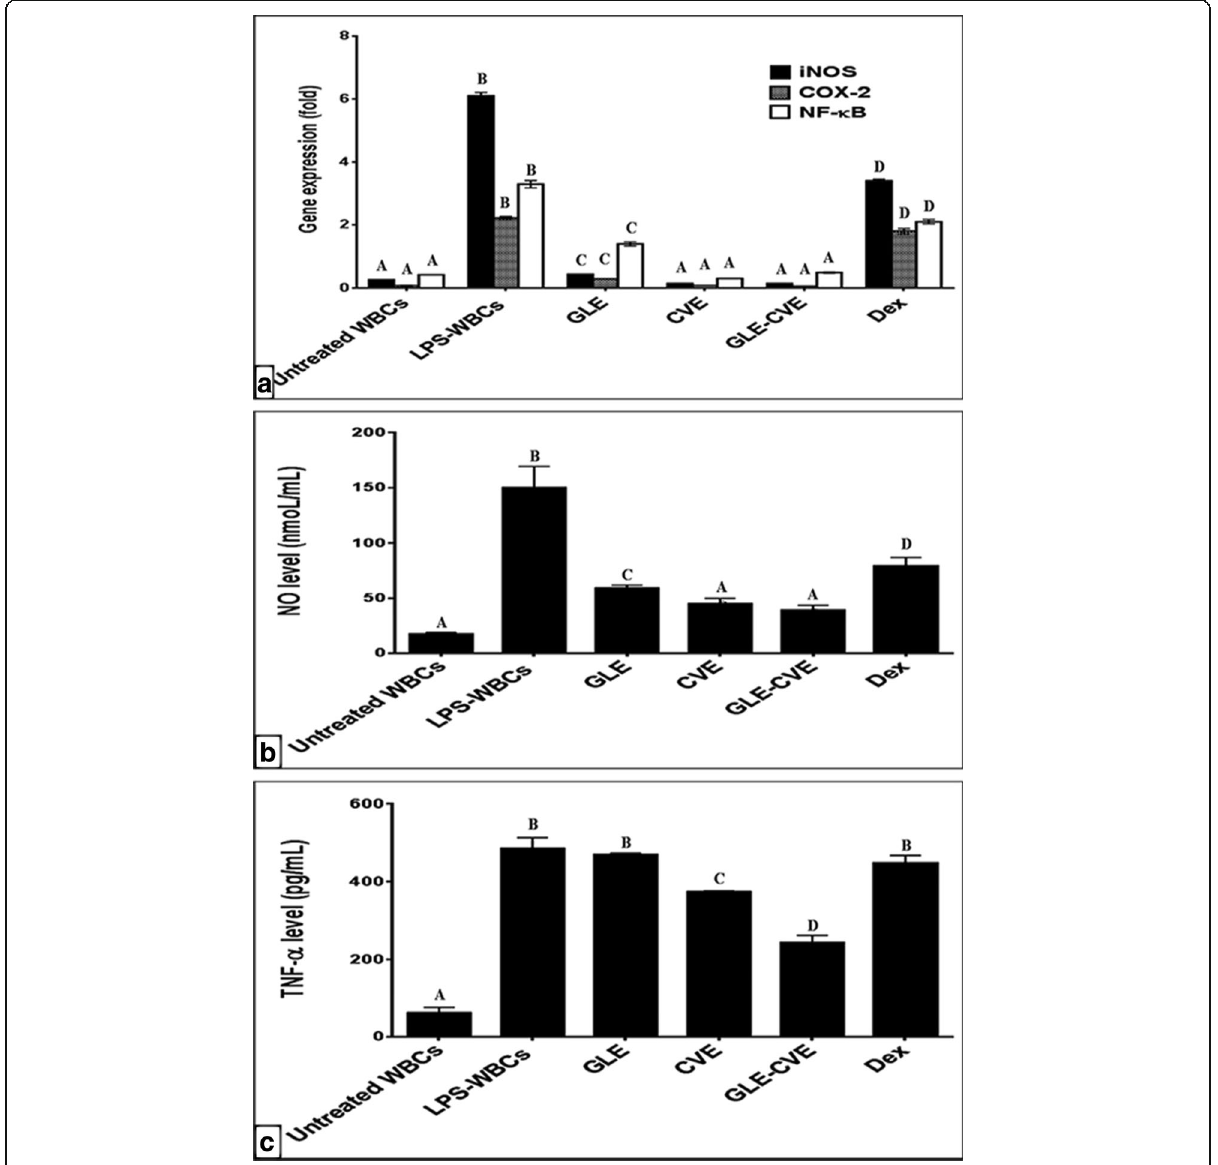
Fig. 4 Effect of GLE, CVE, GLE-CVE combination, and Dex on LPS-induced inflammation in WBCs. (a) the change in gene expression of iNOS, COX- 2, and NF- к B (b) NO level (c) the protein level of TNF- α . Results are expressed as Mean ± S.E. Different letters for the same parameter are signifi- cantly different at p <